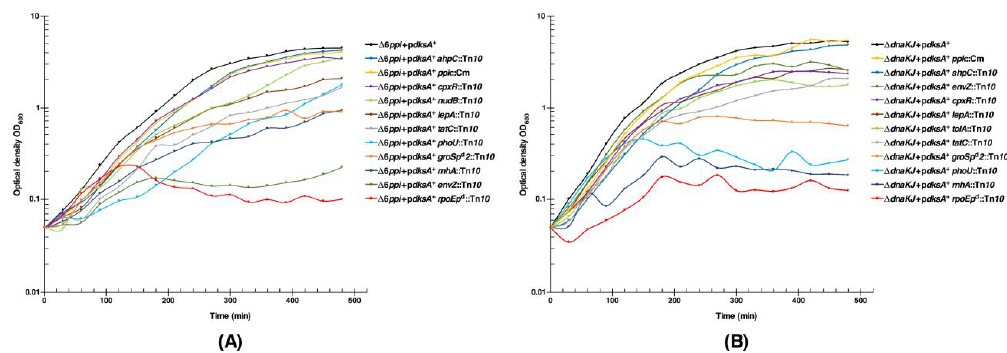
Figure 12. Wild-type levels of RpoE, GroL / S and intact copies of RNase H, TatC and LepA are required for the DksA-mediated suppression of Ts growth of either ∆ 6 ppi or ∆ dnaK / J strains. ( A ) Isogenic cultures of ∆ 6 ppi + p dksA + and its derivatives with either the Tn 10 insertion or deletion were grown overnight in M9 medium at 37 ◦ C. Culture were adjusted to OD6 00 of 0.05 in 10 mL of prewarmed LB medium at 43.5 ◦ C. Aliquots of samples were drawn at di ff erent intervals and the bacterial growth monitored by measuring OD 600 . ( B ) Isogenic cultures of ∆ dnaK / J + p dksA + and its derivatives with gene disruptions were grown in M9 medium at 30 ◦ C and analyzed for the bacterial growth in LB medium at 41 ◦ C by measuring OD 600 . Data presented are from a representative experiment.